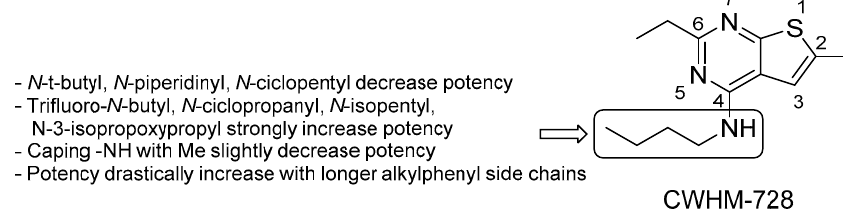
Figure 12. SARs of 4-amino-thieno[2,3- d ]-pyrimidines and the chemical structure of CWHM-728.